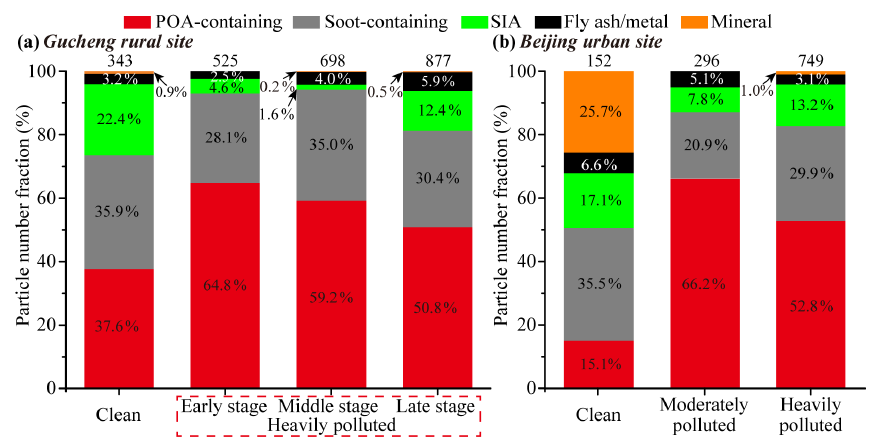
Figure 5. Relative abundance of different particle types in different periods at the (a) Gucheng rural site and (b) Beijing urban site. The numbers of analyzed particles in different periods are shown at the top of each